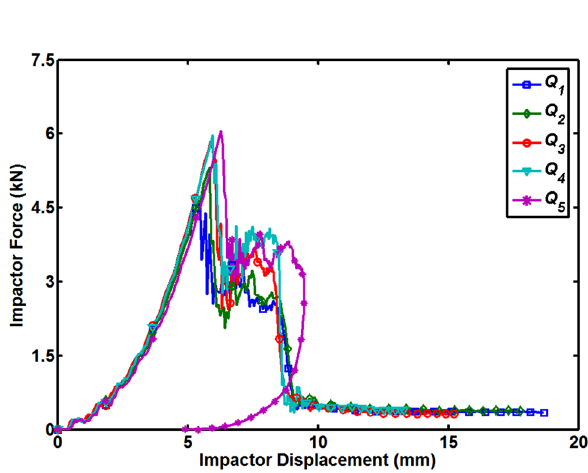
Figure 6. Impact force versus displacement diagram for all quasi-isotropic composite plates.